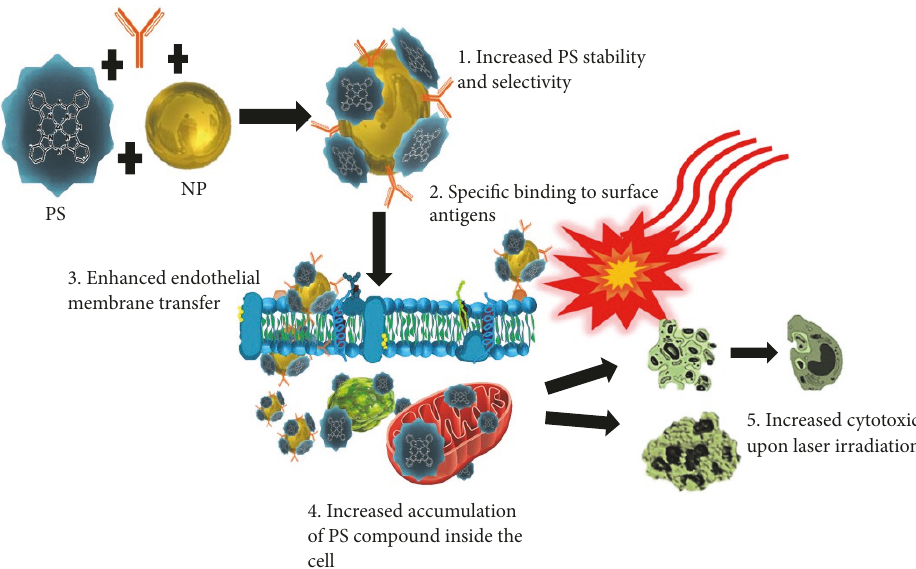
Figure 2: Advantages of using multicomponent photosensitizing molecules and their different roles in TPDT: (1) Conjugating a PS to NPs and antibodies increases its stability in the circulation and tumour selectivity. (2) Antibodies recognise specific antigens on the surface of cells enabling specific binding. (3) Nanoparticles enhance endothelial membrane by increasing solubility. (4) Because of increased solubility, there is maximum absorption resulting in efficient accumulation of photosensitizer inside the cancer cell. (5) Ultimately, there is increased cytotoxic effect in